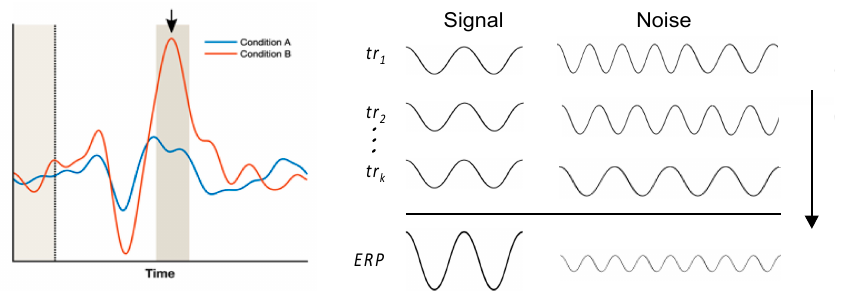
Figure 1. Sample ERP waveforms illustrating experimental methodology and trial averaging process. ( Left ) Brain responses to specific stimuli are measured by contrasting a target experimental condition (Condition B, orange) with a control condition (Condition A, blue). The black arrow indicates the response peak of interest, or ERP component. The black dotted line denotes stimulus onset. ERP components are typically evaluated by quantifying amplitude differences between the two conditions over an interval of interest spanning the peak (dark shaded region). Additional comparisons are also made with the signals during a pre-stimulus baseline interval (light shaded region). ( Right ) ERP waveforms are generated through conditional averaging of several trials (“tr”), each consisting of signal and noise components. This process relies on the event-related neurophysiological signal of interest (“Signal”) having relatively similar morphology and latency in each trial, in contrast to the noise components (“Noise”) being relatively dissimilar from trial to trial, leading to signal-to-noise increases by a factor of √ k.